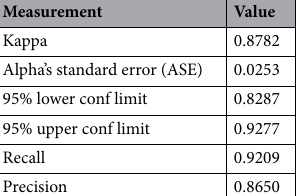
Table 6. Cohen’s kappa coefficient, recall and precision results for the multi-lameness